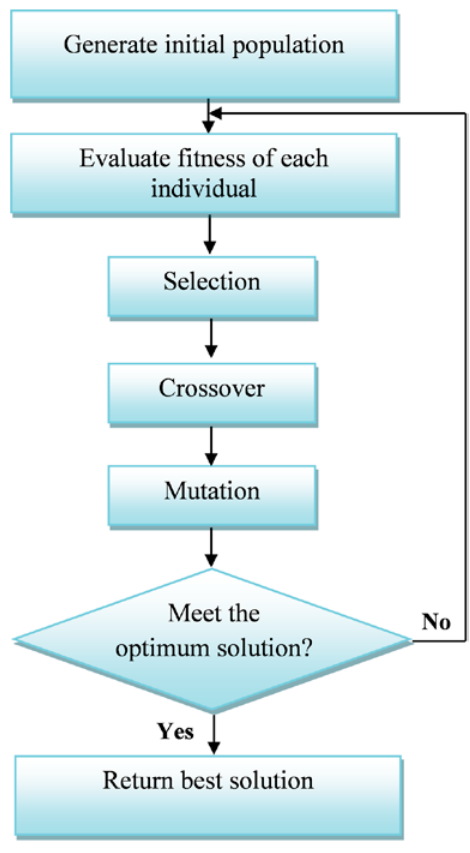
Fig. 1. The genetic algorithm process Source: adapted from (Amjadi et al . 2010). GAs work according to selection rules as